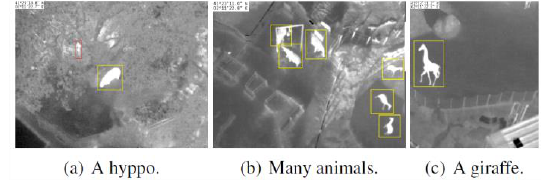
Figure 7: Thermal images processed by